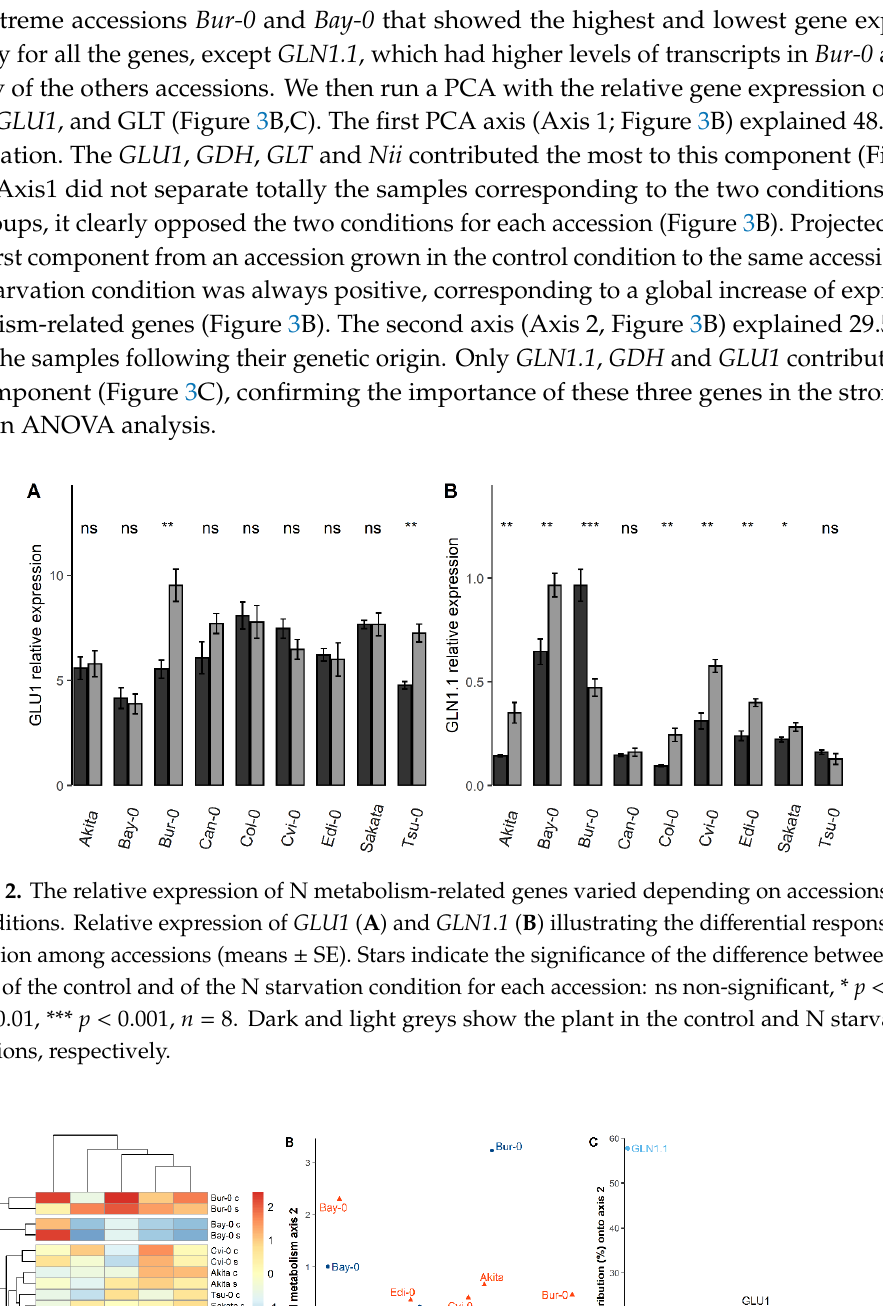
Table 1. Averages on all accessions of differential gene expression between the control and starvation conditions.